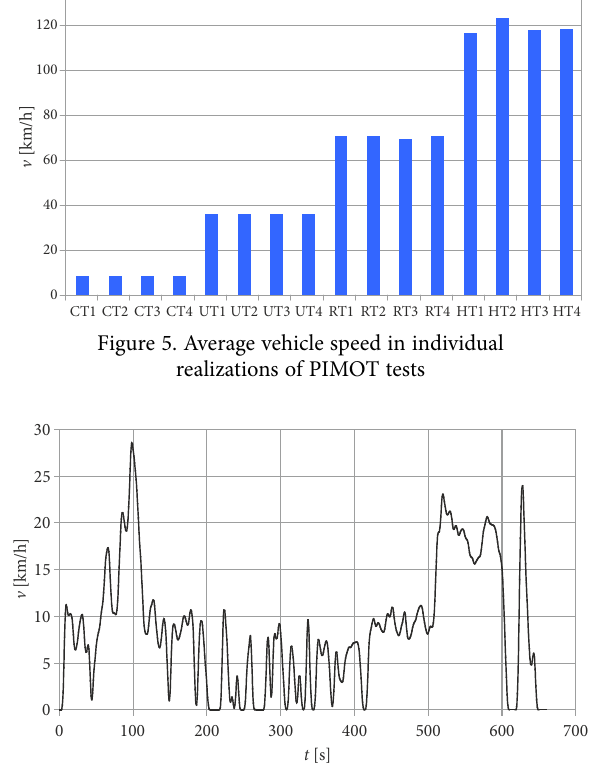
Figure 6. Vehicle speed v vs. time t curve in the CT1 test